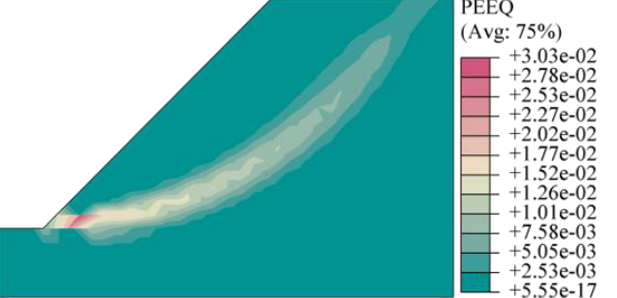
Figure 5. Equivalent plastic strain cloud calculated by the traditional finite element reduction method.